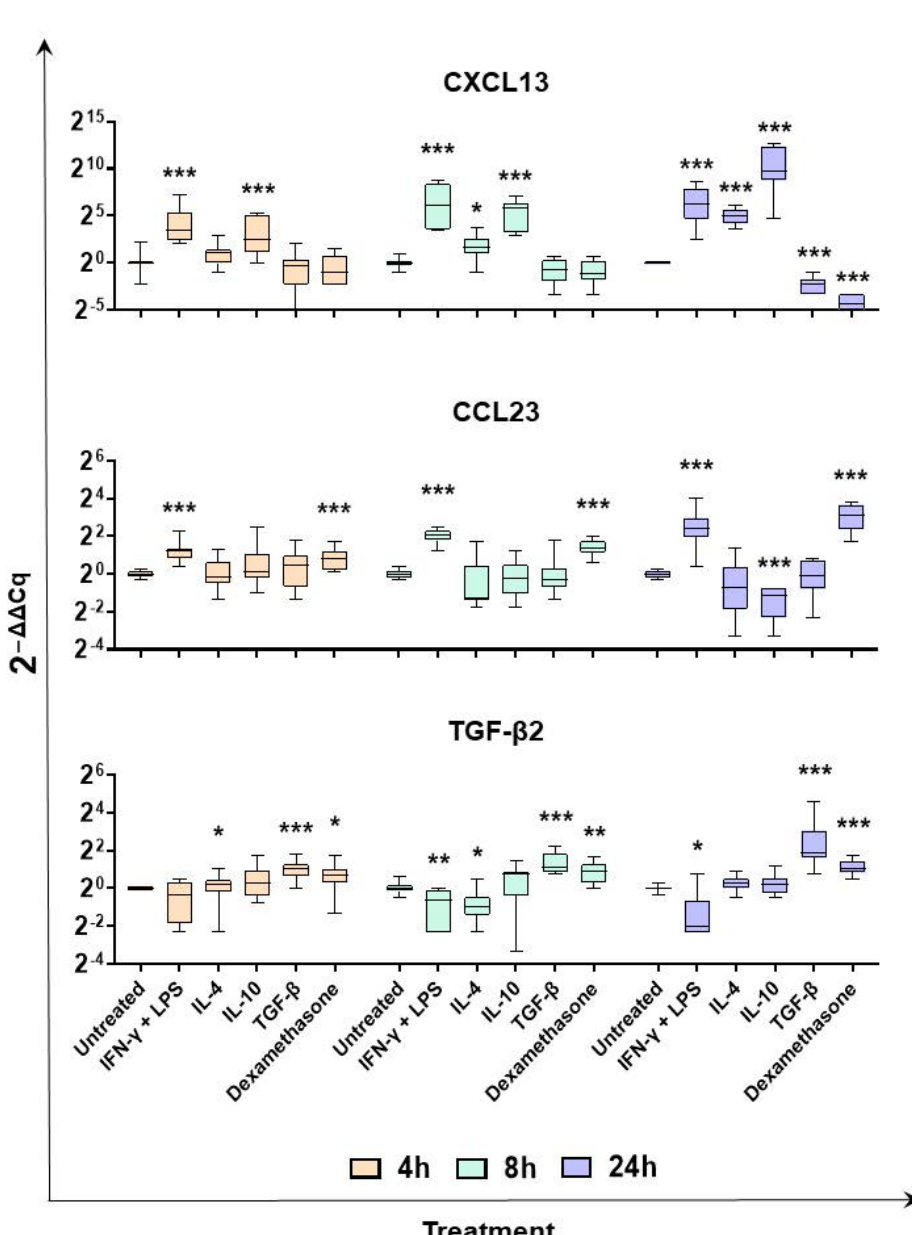
Figure 5. Expression of TGF- β 2, CXCL13, and CCL23 over time in moM Φ stimulated with diverse polarizing factors. Porcine moM Φ were left untreated, or they were stimulated with diverse polarizing factors: IFN- γ + LPS (both at 100 ng/mL), IL-4 (20 ng/mL), IL-10 (20 ng/mL), TGF- β (20 ng/mL), or dexamethasone (20 ng/mL). At 4, 8, and 24 h post-stimulation, gene expression levels of TGF- β 2, CXCL13, and CCL23 were determined using qPCR. At each timepoint, data were normalized to the values of the untreated control (moM Φ ) and expressed as 2 − ∆∆ Cq , where ∆ Cq = Cq (target gene) − Cq (house-keeping gene), and ∆∆ Cq = ∆ Cq (stimulated samples) − ∆ Cq (untreated samples). Data from five independent experiments utilizing different blood donors are presented. Data are displayed as box-and-whisker plots, showing the median and interquartile range (boxes) and minimum and maximum values (whiskers). Values of treated macrophages were compared to the untreated control (moM Φ ), using a Mann–Whitney test. *** p < 0.001, ** p < 0.01, and * p <